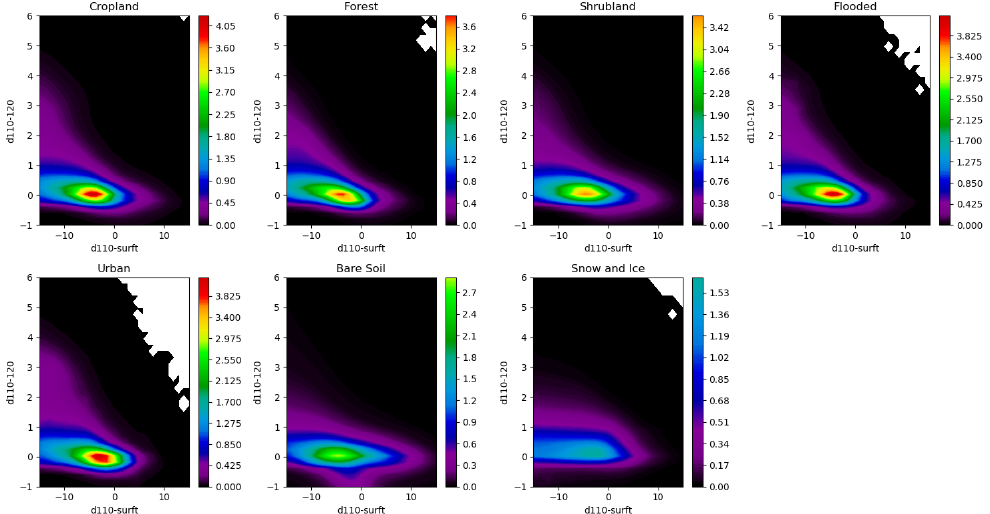
Figure 2. PDF 1 (Table 1) plots for different biome classifications. Plots show the 11.0 µ m-NWP surface temperature (d110-surft) as a function of the 11.0–12.0 µ m channel difference (d110–120). PDFs are for near-nadir observations (the first atmospheric path length bin) and summed over all NWP surface temperature bins. The colour bars use consistent shading between plots with different maxima dependent on the data density.